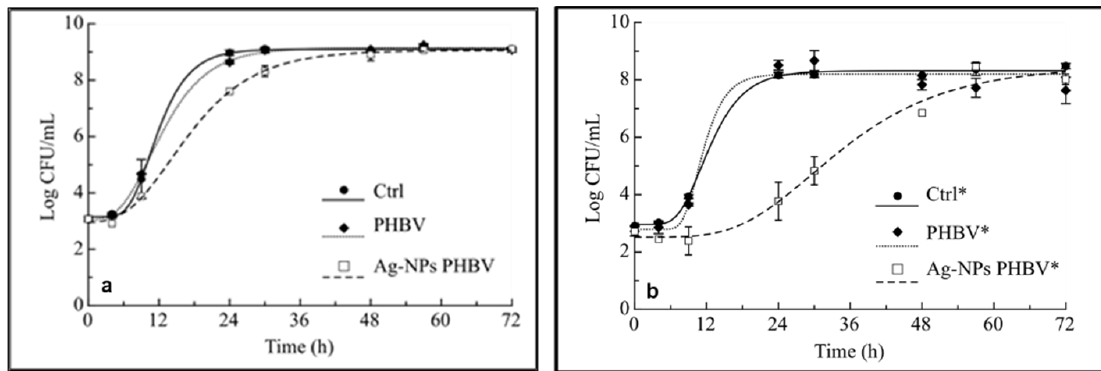
Figure 4. Evolution of Pseudomonas mix ( P. fluorescens and P. putida ) plotted during time. ( a ) Ctrl: bare inoculated sample; PHBV: inoculated sample with PHBV (4 cm 2 ); AgNPs-PHBV: inoculated sample with AgNPs-PHBV (4 cm 2 ). ( b ) Ctrl*: bare inoculated sample; PHBV*: inoculated sample with PHB (8 cm 2 ); AgNPs-PHBV*: inoculated sample with AgNPs-PHBV (8 cm 2 ).